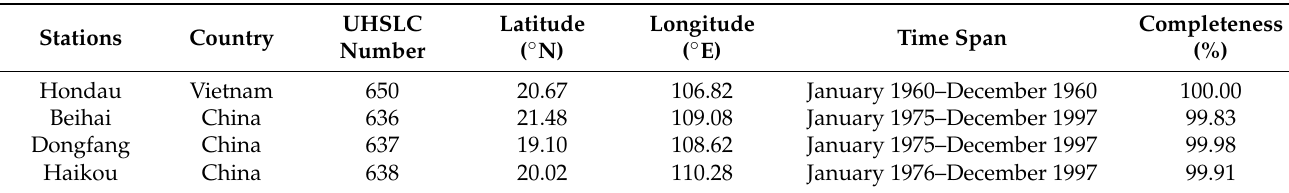
Table 1. Details for four hourly tide gauges in the Gulf of